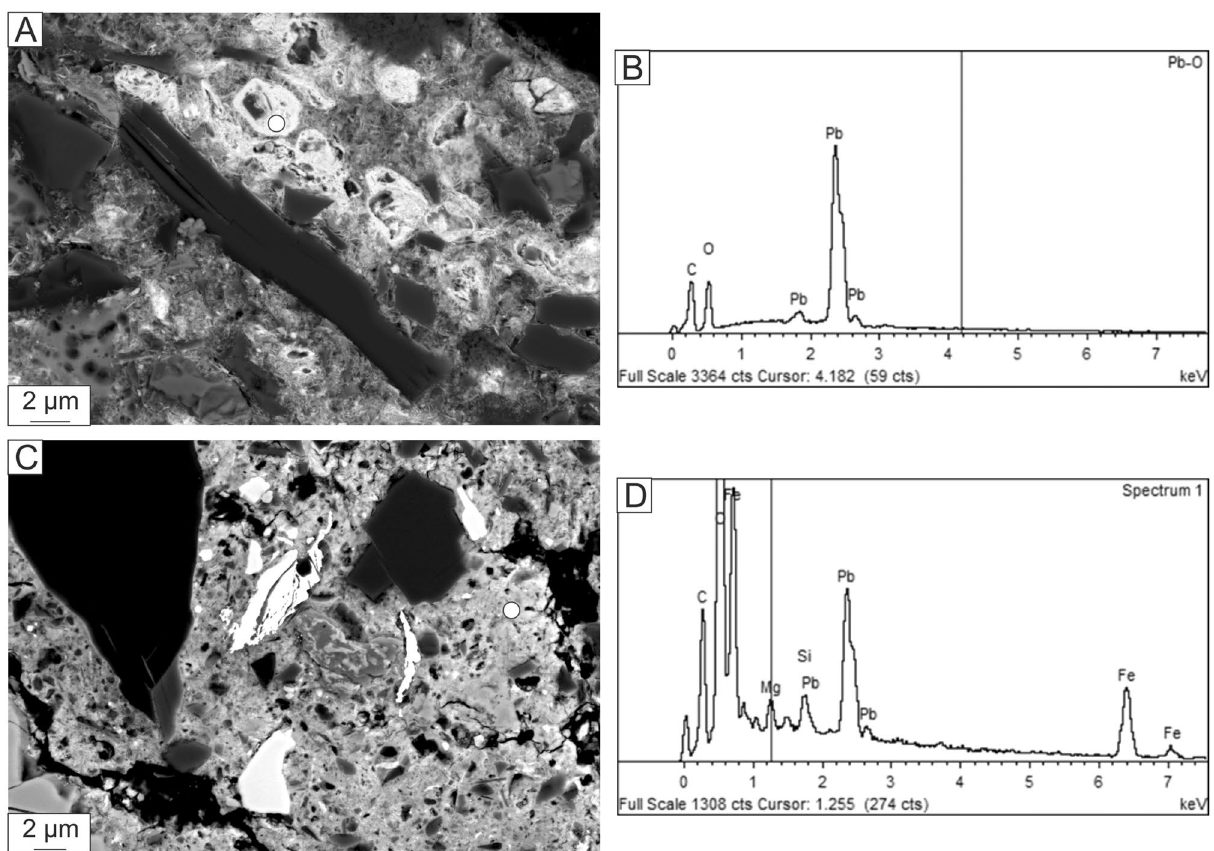
Figure 4. Characterization of fine-grained material from exogenous fracture fill. ( A ) BSE image and ( B ) EDS spectrum of PbO grain adjacent to margarite. ( C ) BSE image and ( D ) EDS spectrum of the Pb–Fe-rich